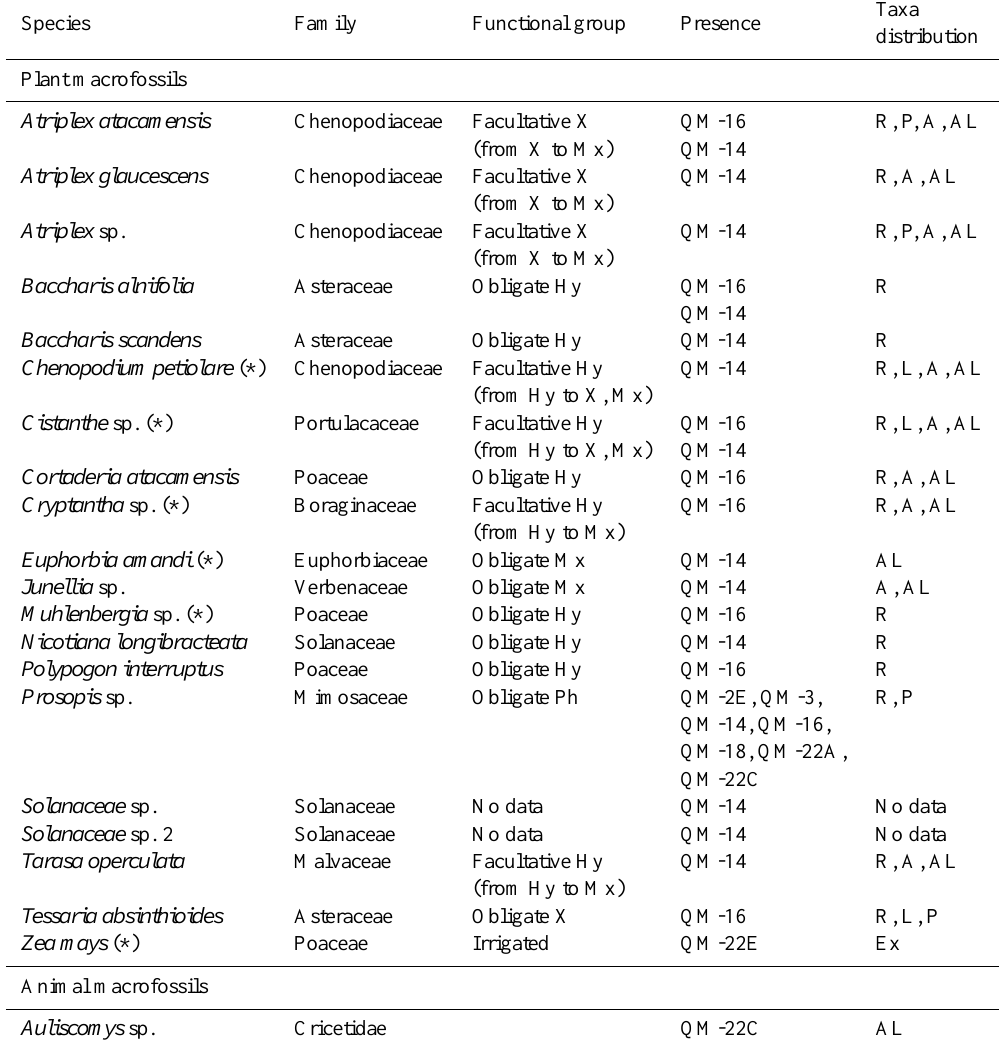
Table 2. List of taxa identified from macrofossil analyses on leaf-litter and rodent deposits from Quebrada Man´ı. (*) Indicates annual phenology. Functional group for each plant species: (Hy) Hygrophyte, (X) Xerophyte, (Ph) Phreatophyte and (Mx) Mesoxerophyte. Taxa distribution at major Northern Atacama Desert vegetational formations: (R) Riparian, (L) Lomas, (P) Pampa, (A) Andean, (AL) Altiplano and Exotic